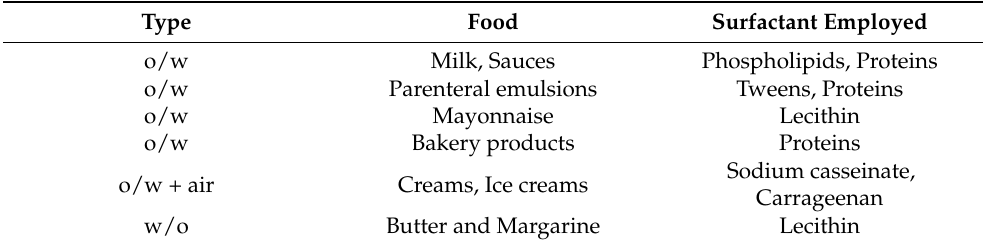
Table 1. Typical food colloids and the surfactants employed in their kinetic stabilization. Adapted from ref. [4,7].